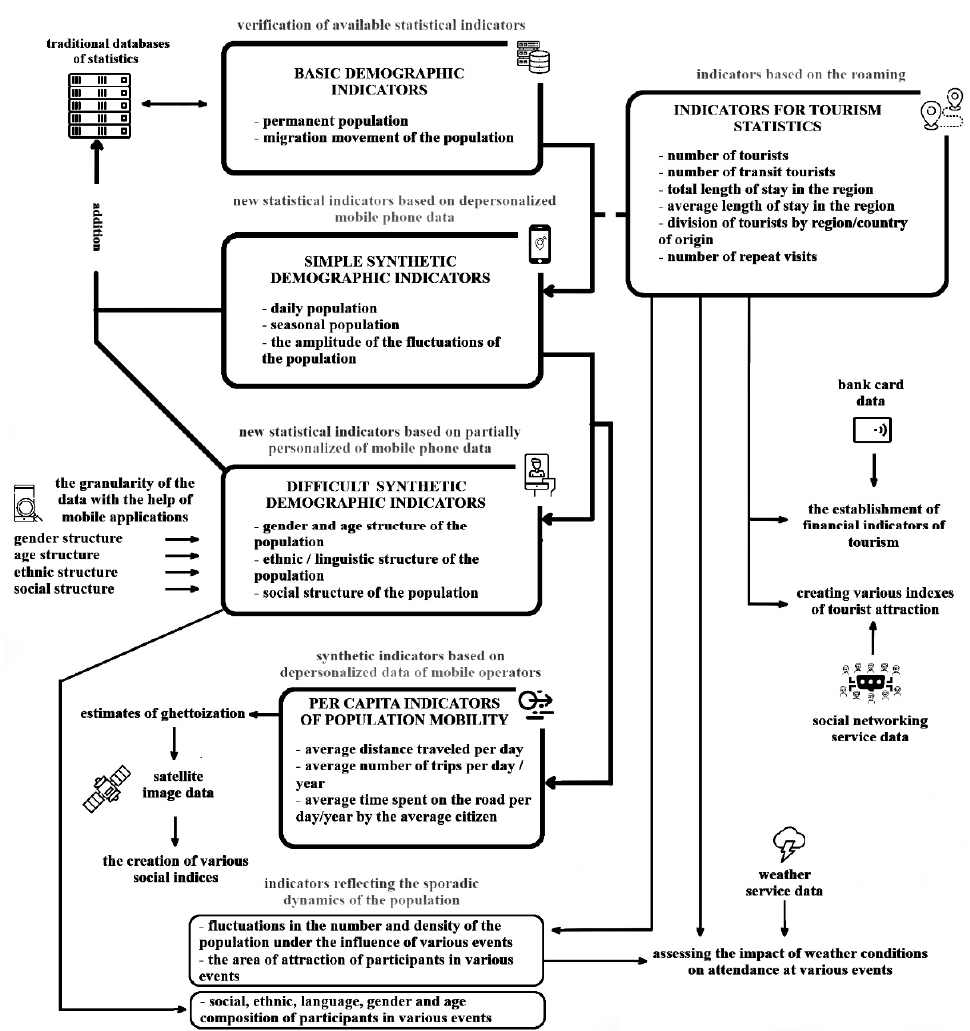
Figure 4. A promising system of statistical indicators obtained by integrating mobile operators’ data into statistics. Source: compiled by the into statistics. Source: compiled by the author.